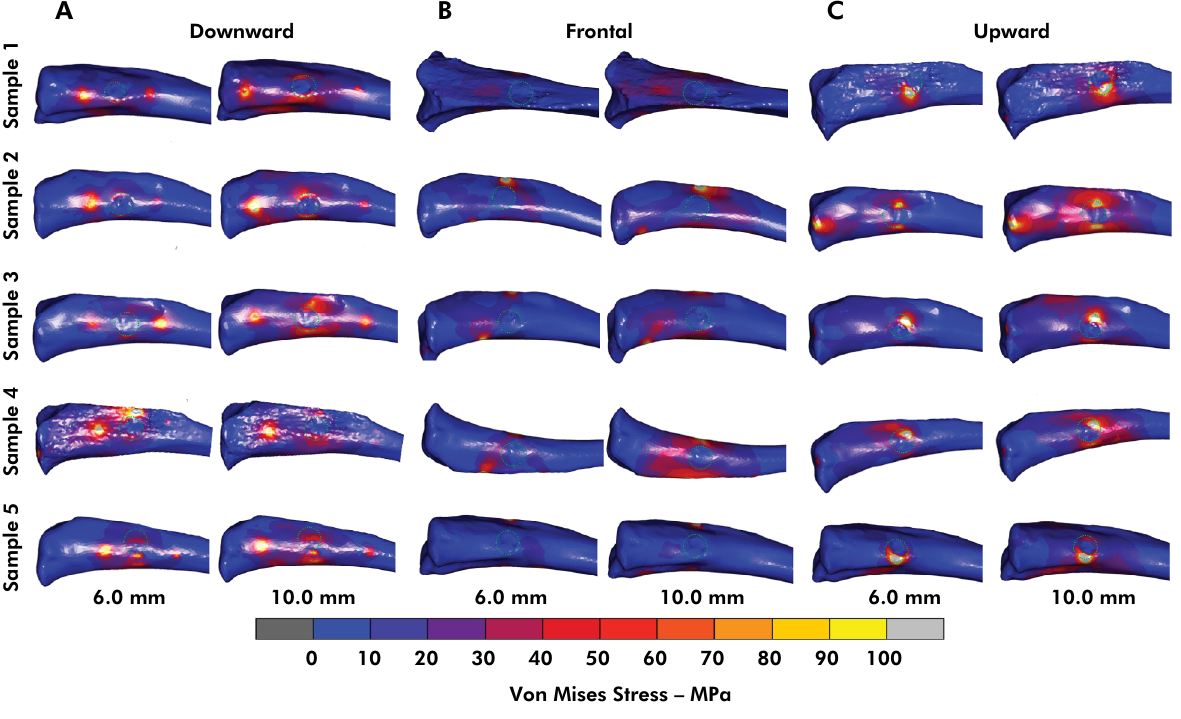
Figure 5. Von Mises stress distributions at the surface of the rat tibiae when the defect was positioned downward, frontal or upward during three-point bending